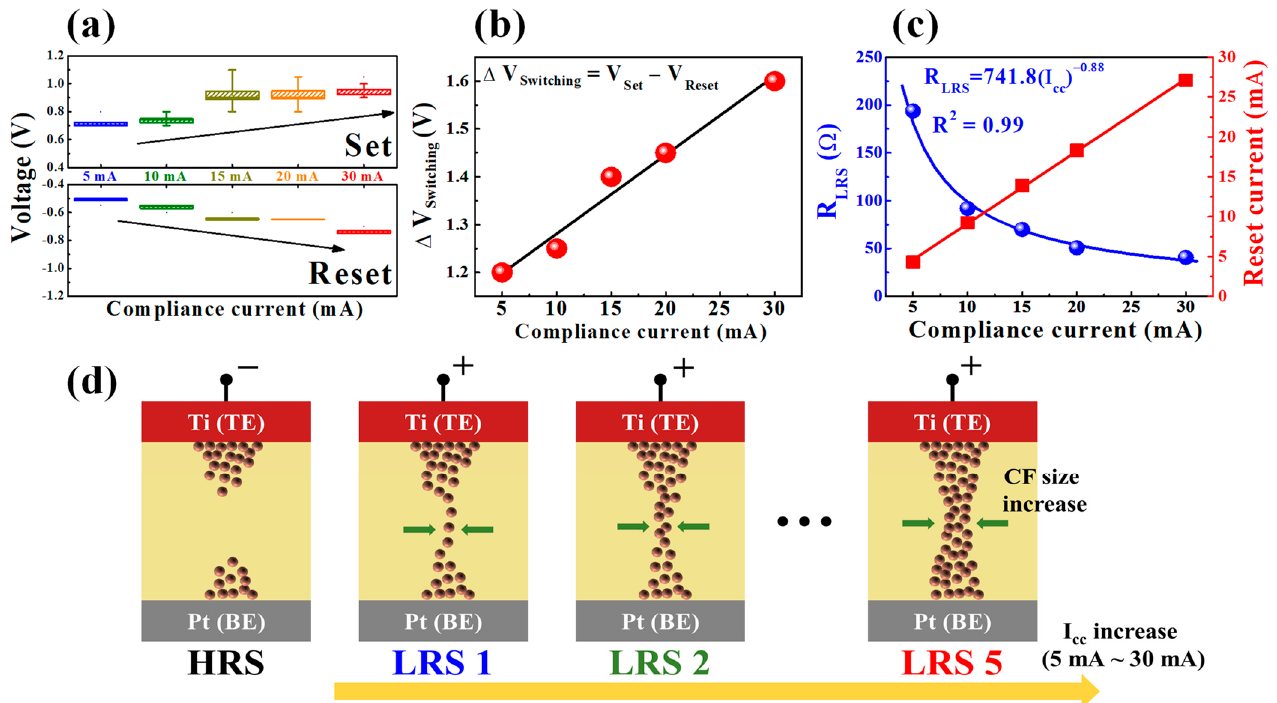
Figure 4. ( a ) Effects of the set I cc value on the set operating voltage ( V set ) and reset operating voltage ( V reset ) distribution. ( b ) Dependence of operating voltage margin ( Δ V switching ) on the I cc during repetitive cycling. ( c ) Dependence of LRS resistance ( R LRS ) and reset current ( I reset ) on the set I cc value. ( d ) Schematic illustration of the multilevel RS operation mechanism with variations of the set I cc value. TE: top electrode and BE: bottom electrode.